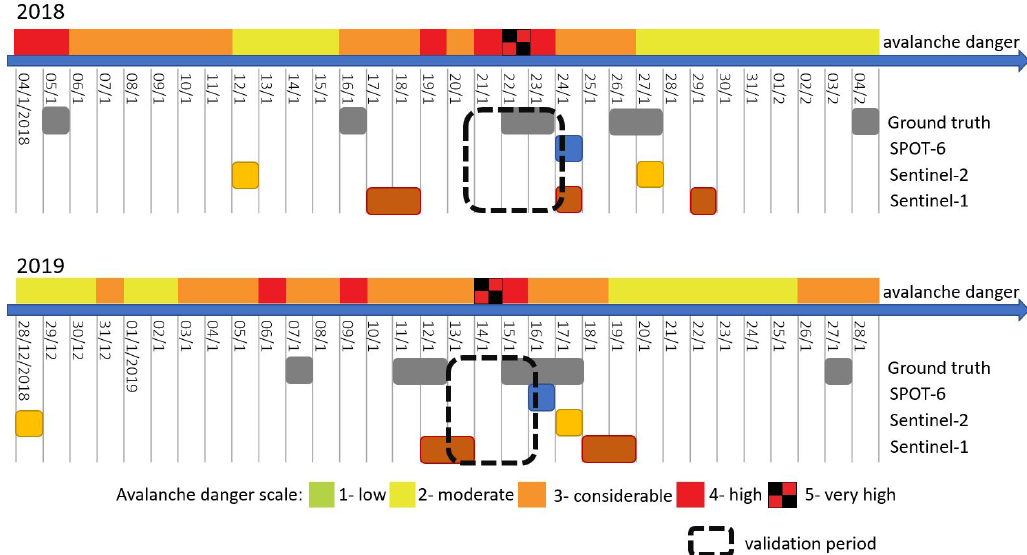
Figure 2. Temporal overview of the two validation periods (marked by the dashed, black squares) and the respective days when ground-truth images and satellite data were captured (marked by colored boxes). On top the highest avalanche danger level forecasted in the validation area is shown for each day. Table 1. Properties of the data acquired by the optical sensors (SPOT 6 and Sentinel-2 – S2A and S2B). Satellite Acquisition time (UTC) Inclination angle Spatial resolution of used bands Spectral resolution of used (m)